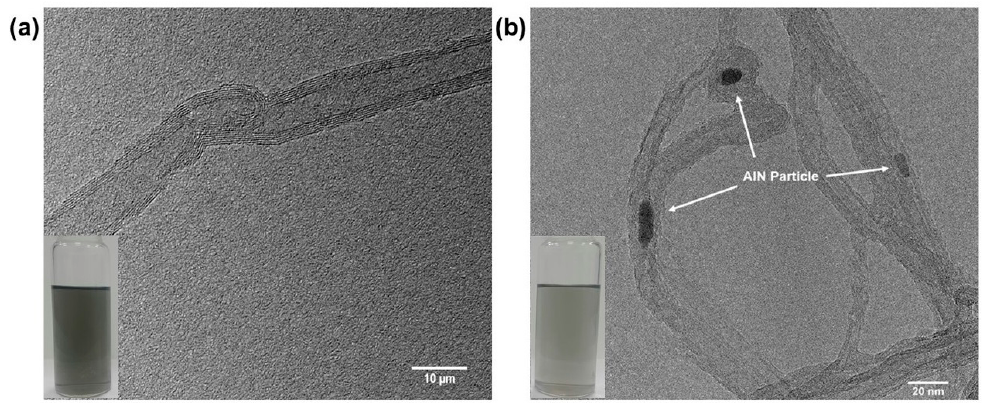
Figure 6. TEM image of ( a ) fMWCNTs; and ( b ) AlN grafted MWCNTs (Inserted images were the MWCNTs dispersion in Ethanol medium).